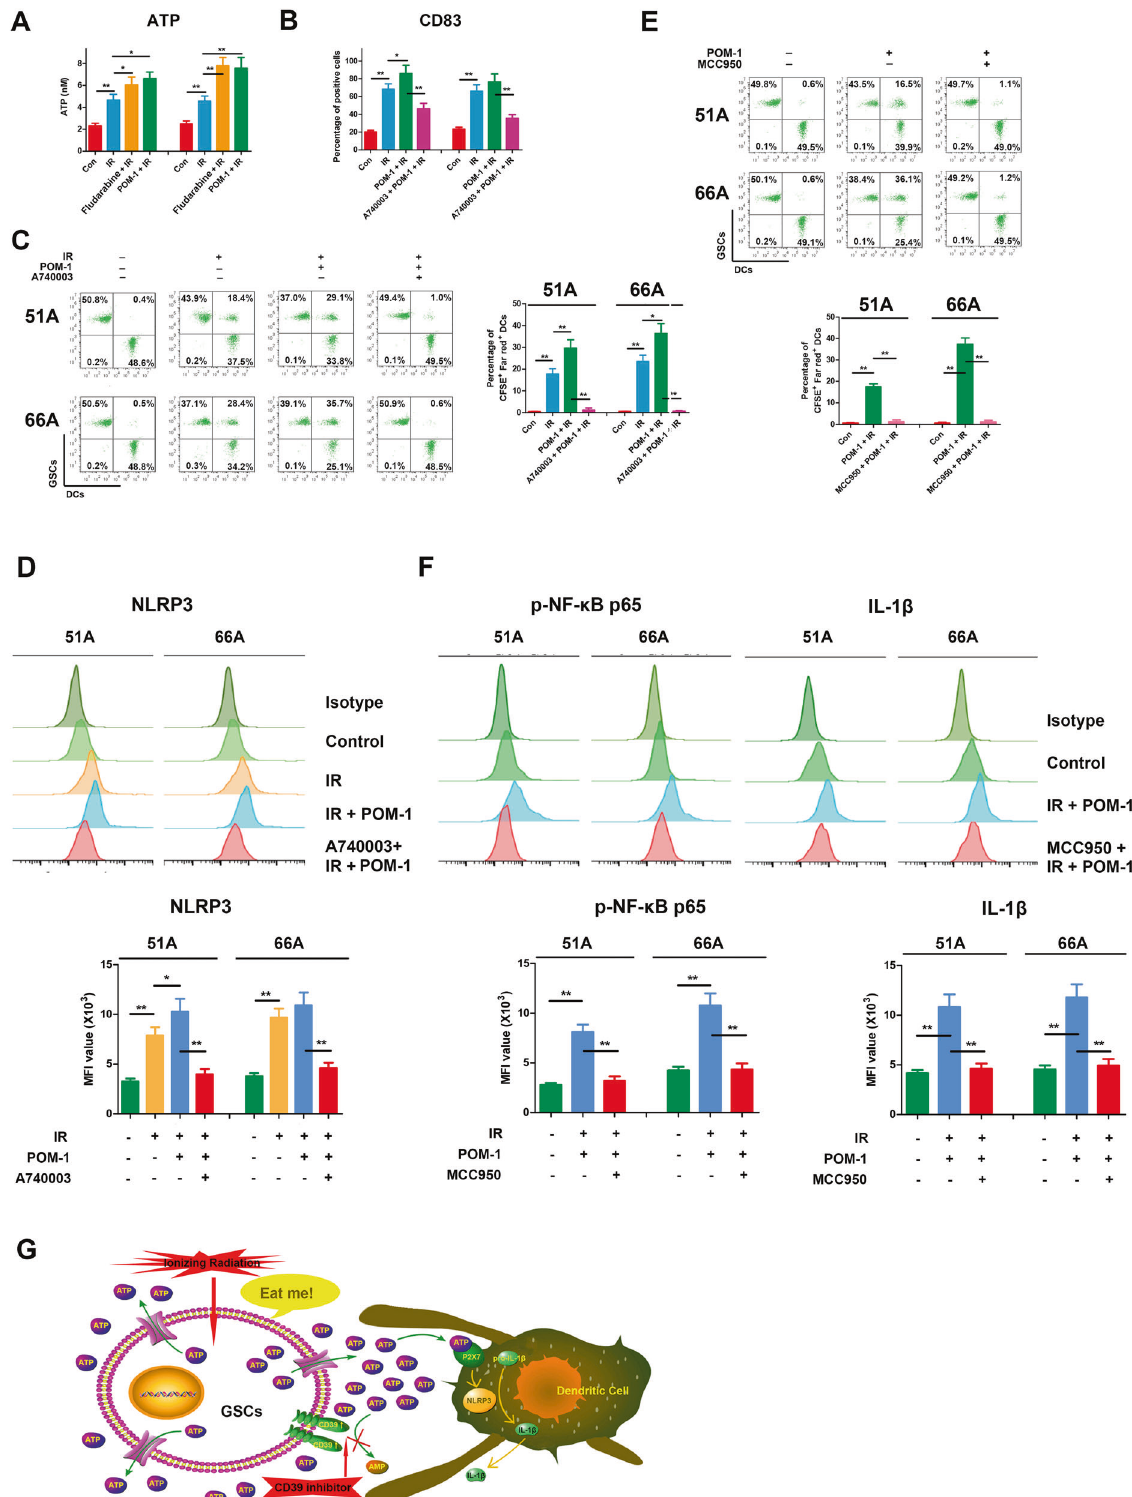
treatment (Fig. 6C). Meanwhile antitumor activity of ICD- activated hEGFRvIII CAR-T cells was evaluated using orthotopic tumor model. Compared with CAR-T groups, the tumor size treated with ICD-activated hEGFRvIII CAR-T cells (POM-1 and IR) was progressively decreased (Fig. 6E, G), and the survival of mice